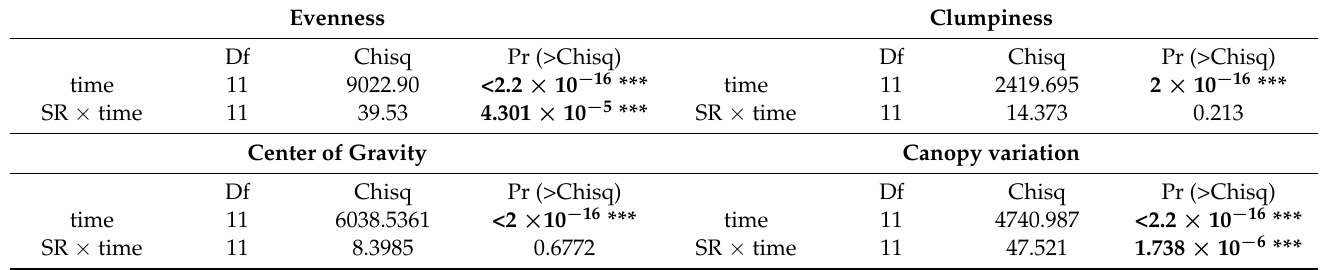
Figure 4. Temporal distribution of four community canopy structural components throughout the growing season: ( A ) evenness (calculated as the sum of volume proportions of each of the five strata per total volume of the plot divided by 5); ( B ) clumpiness (calculated via Geary’s ( C ) index that measures the spatial distribution of clusters in the rasterized 3D point cloud for each plot where values close to zero indicates less clumpiness (similar clusters) while values close to 1 display high clumpiness (dissimilar clusters)); ( C ) center of gravity (displayed as a categorical measure of the strata of height with the highest volume proportion to the total volume per 5 strata); ( D ) canopy variation (calculated as the area of fitted surface mesh on the canopy divided by plot area). See details in Section 2.2.1. Table 2. Type II analysis of variance table with Kenward–Roger’s method showing the results with the fixed-effects part of the mixed-effects models considering the effects of diversity (“SR”) on each community canopy structure metrics over the growing season (“time”). Restricted maximum likelihood estimated the variance components of the mixed effect models. Values in the columns are numerator degrees of freedom (Df), chi-square test (Chisq), and p -values (Pr (>Chisq)). Significant relationships are in bold and follow the codes for significant relationships: 0 ‘***’ 0.001 ‘**’ 0.01 ‘*’ 0.05